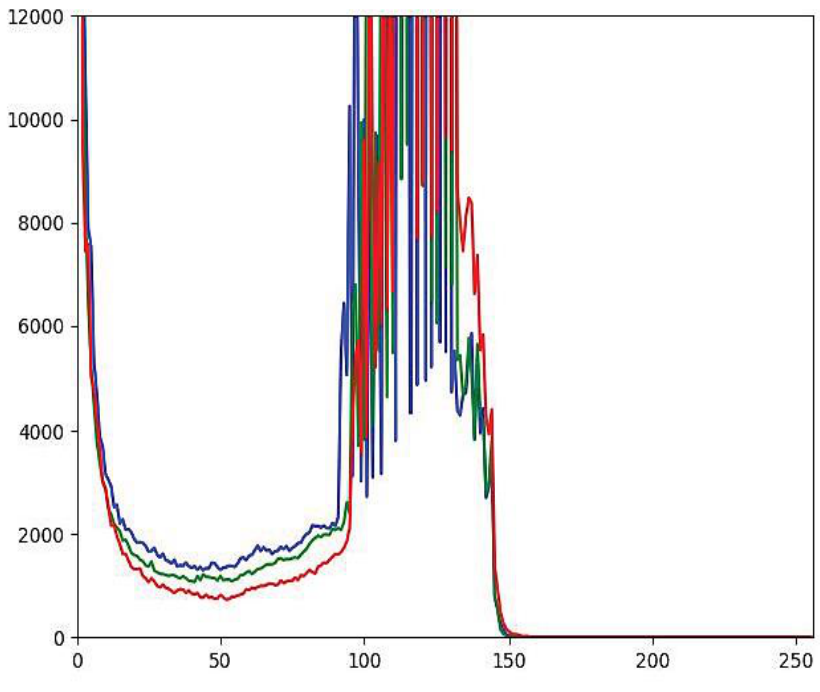
Figure 41. Histogram of RGB graph for the image (see Figure